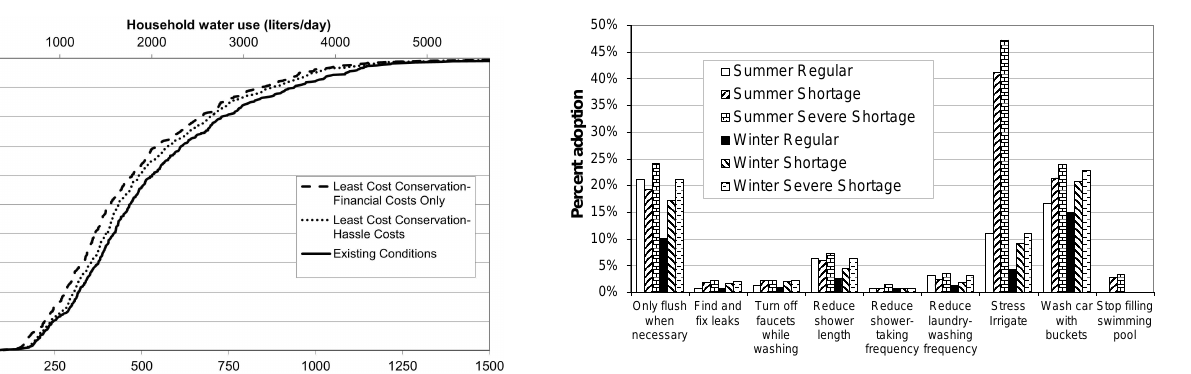
Fig. 6. Modeled average market penetration for short-term conser- vation actions by season and drought event, base conditions with hassle costs.